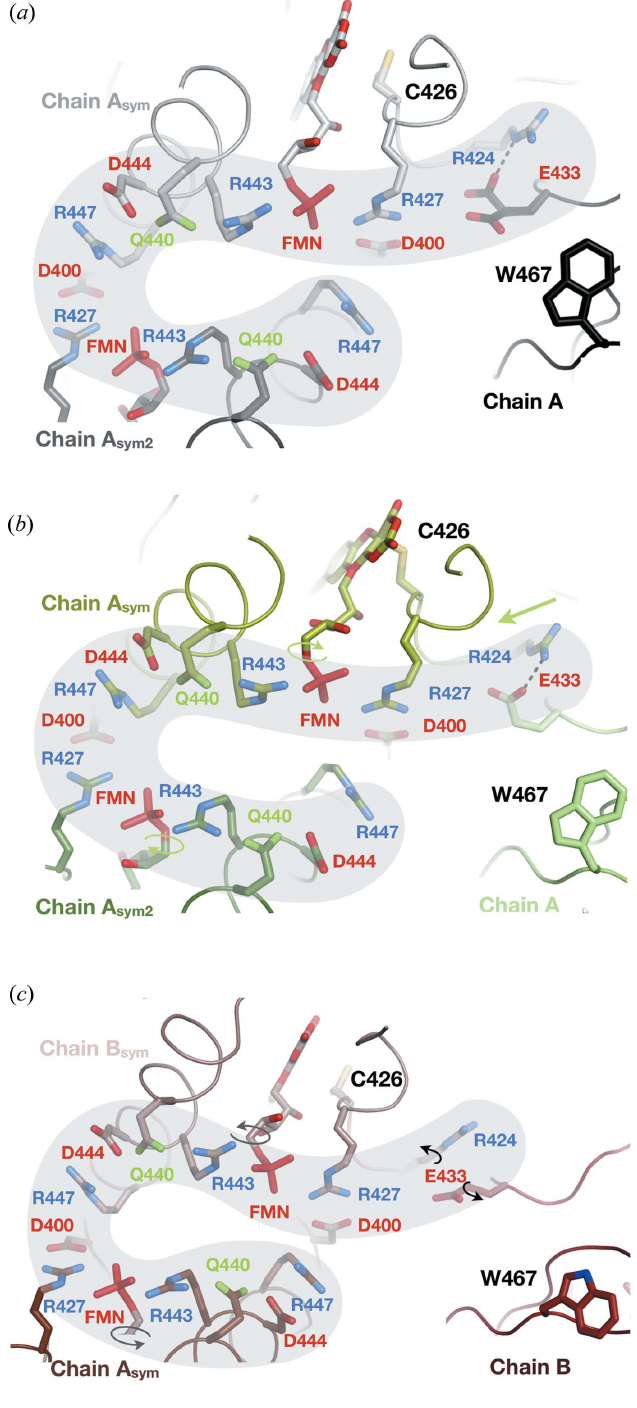
Figure 9 Effect of photoadduct relaxation on the electrostatic network connecting symmetry-related chains. ( a ) The D-state structure is displayed as a black ribbon, and the symmetry-related molecules A sym and A sym2 as light-grey and dark-grey ribbons. ( b ) The L-state structure is displayed as a green ribbon, and the symmetry-related molecules A sym and A sym2 as split-pea- and forest-coloured ribbons. ( c ) The D 00 -state structure is depicted as a firebrick ribbon and the symmetry-related molecules A sym and B sym as dark salmon and chocolate, respectively. Negatively and positively charged residues are depicted in red and blue, respectively, and key residues are represented as sticks. The black dashed line highlights the presence of a salt bridge in the D-state and L-state